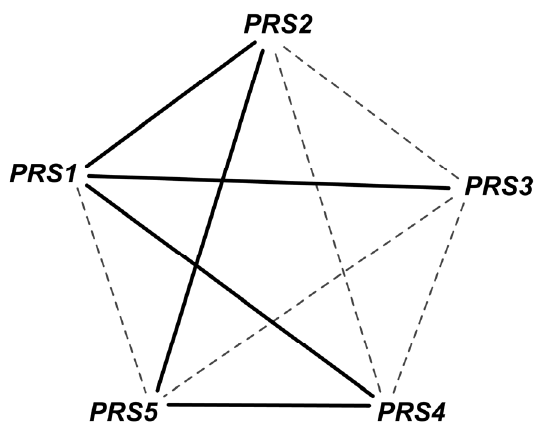
Figure 4. Gene combinations for PRPPS reaction. The gene pairs connected by solid edges are capable for catalyzing the reaction. Any such simultaneous gene deletion (such as prs1-prs5 double deletion) that prevents the formation of all of these solid-line-connected gene pairs is lethal for the